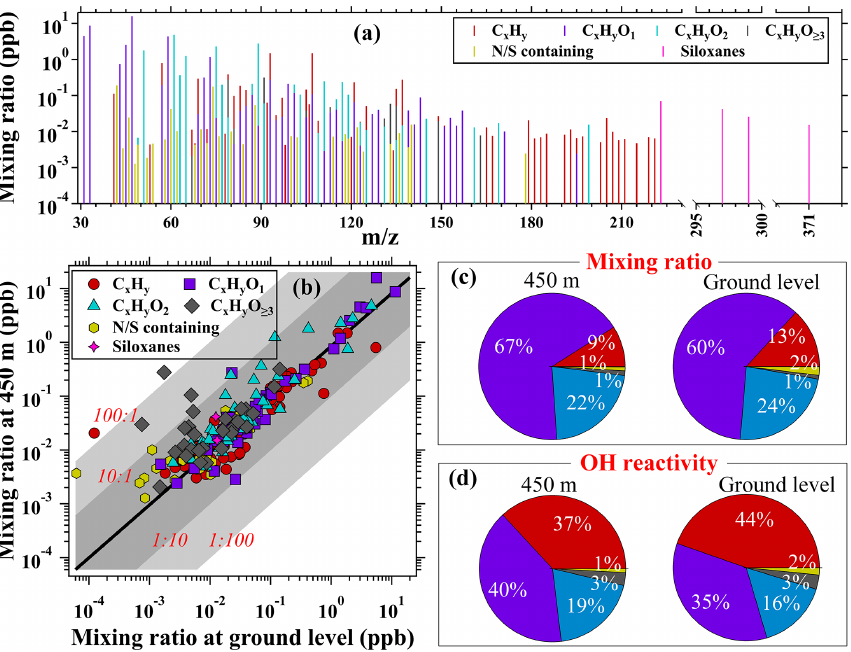
Figure 2. (a) Average mass spectra of VOCs (including 225 species) obtained by PTR-ToF-MS measured at 450m during the CTT campaign. (b) Scatter plots of the average VOC mixing ratios measured at 450m during the CTT campaign versus those measured at ground level during the GIG campaign; the black solid line indicates the ratio of 1 : 1; the dark grey shaded areas indicate the ratios of 10 : 1 and 1 : 10; the light grey shaded areas indicate the ratios of 100 : 1 and 1 : 100. (c, d) Average contribution percentages of the six VOC categories to their total concentrations and OH reactivities at 450m and the ground level, respectively. Only the VOC species that have known reaction rate constants with the OH radical (Table S1) were used for